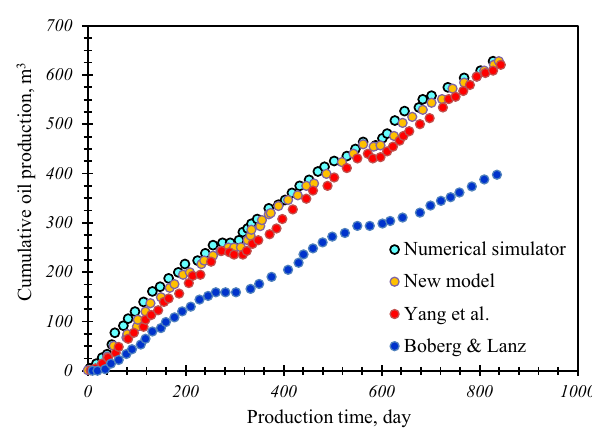
Fig. 4 Comparison of the predicted results from different models neglecting the non-Newtonian fluid